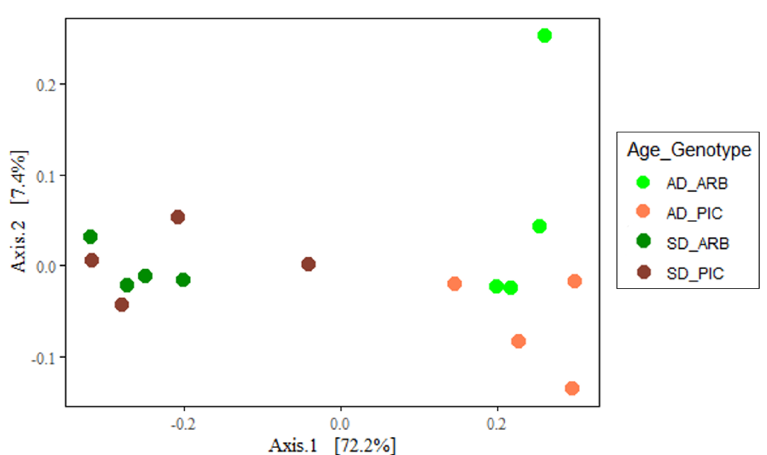
Figure 2. Principal coordinates plot of weighted UniFrac distances of bacterial communities, at ASV taxonomic level, in xylem sap of plantlets (SD) and adult (AD) olive trees of ‘Picual’ (PIC) and ‘Arbequina’ (ARB) genotypes.